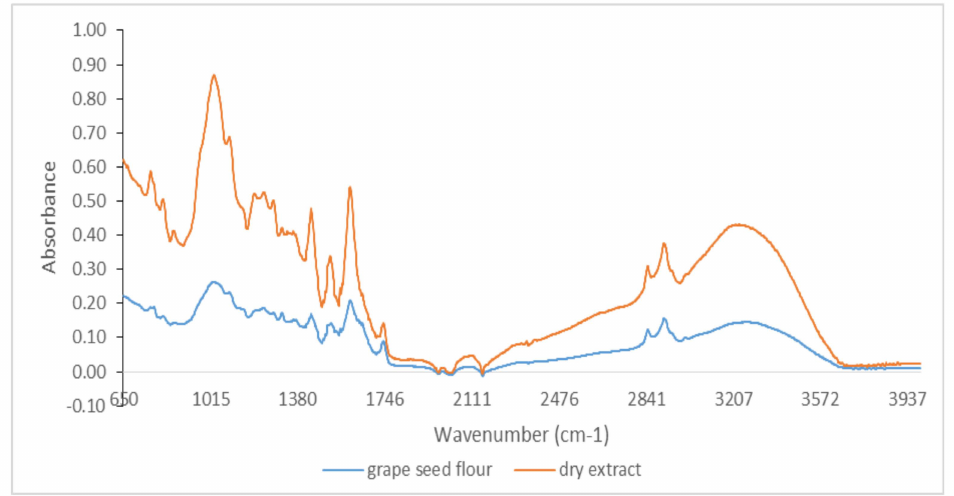
Figure 2. FTIR spectra for grape seed flour and its dry extract in the region between 650 and 4000 cm − 1